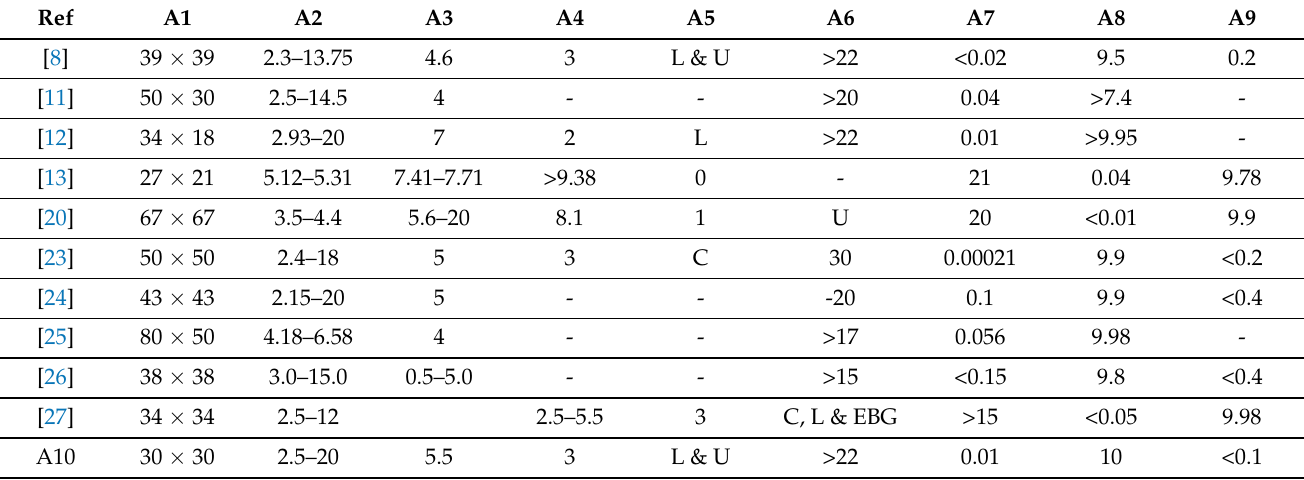
Table 2. Comparison of proposed antenna with existing